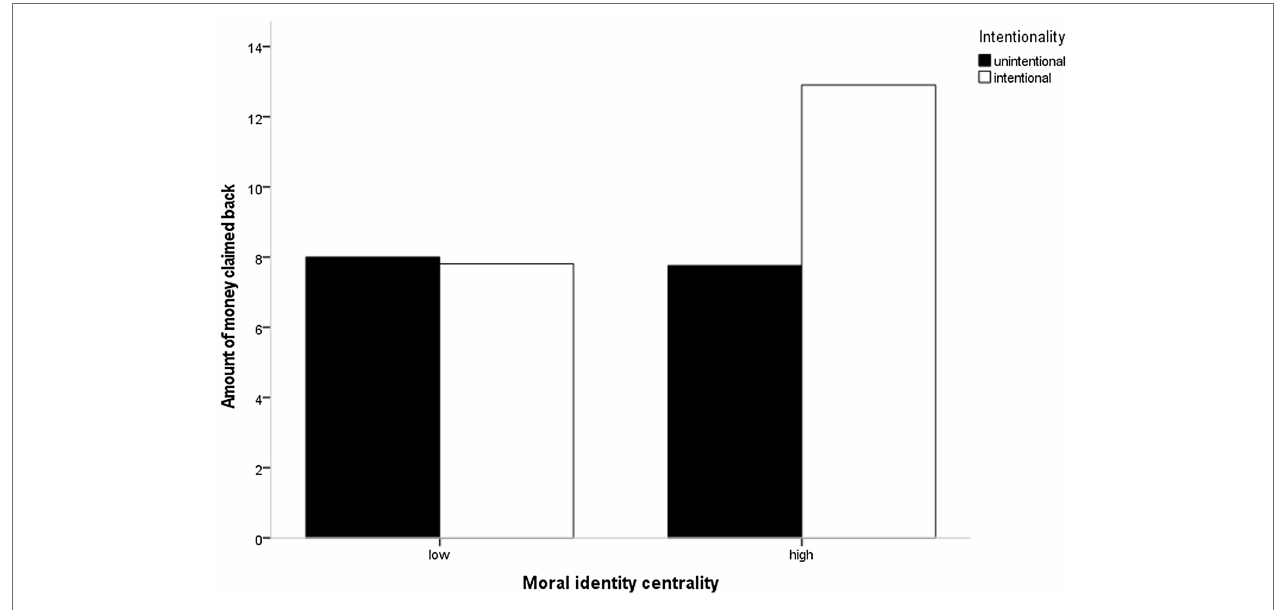
FIGURE 1 | Interaction between moral identity salience and transgression intentionality on the amount of money claimed back in Study